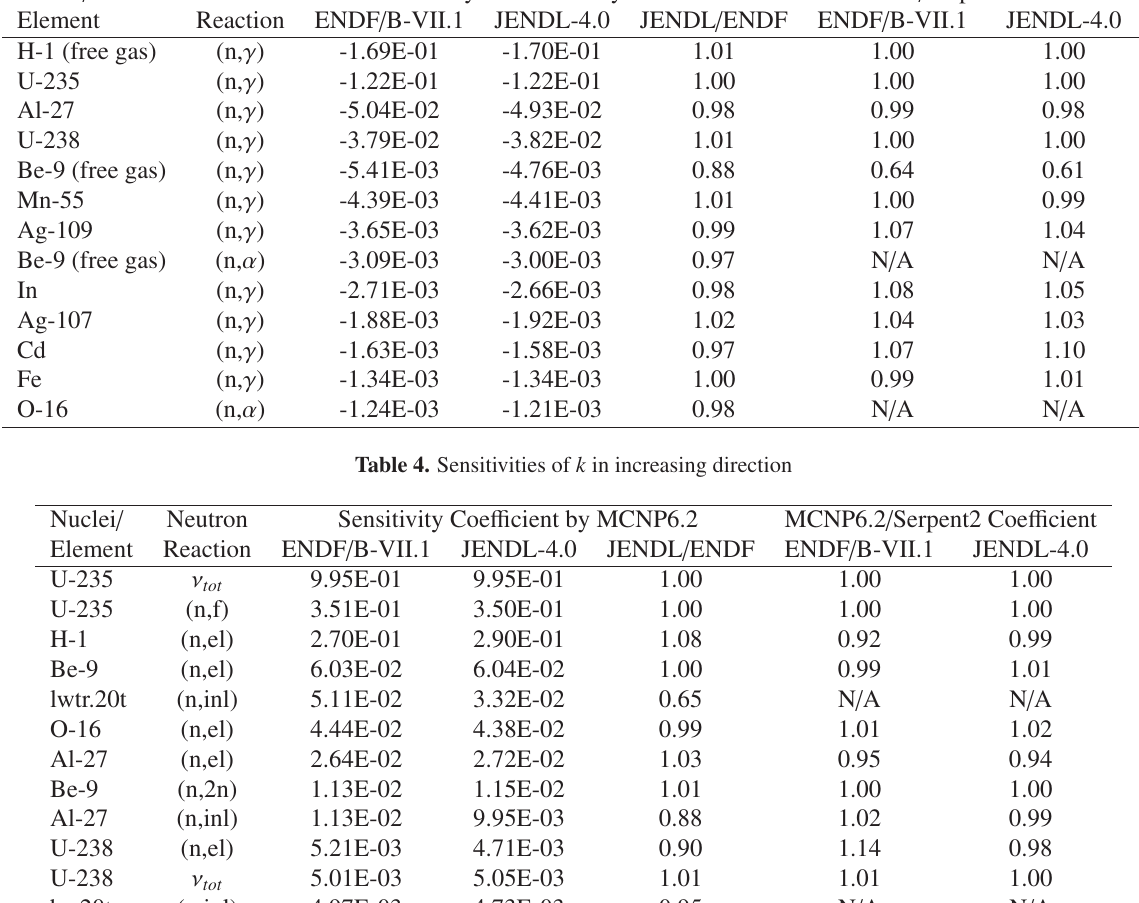
Table 3. Sensitivities of k in decreasing direction